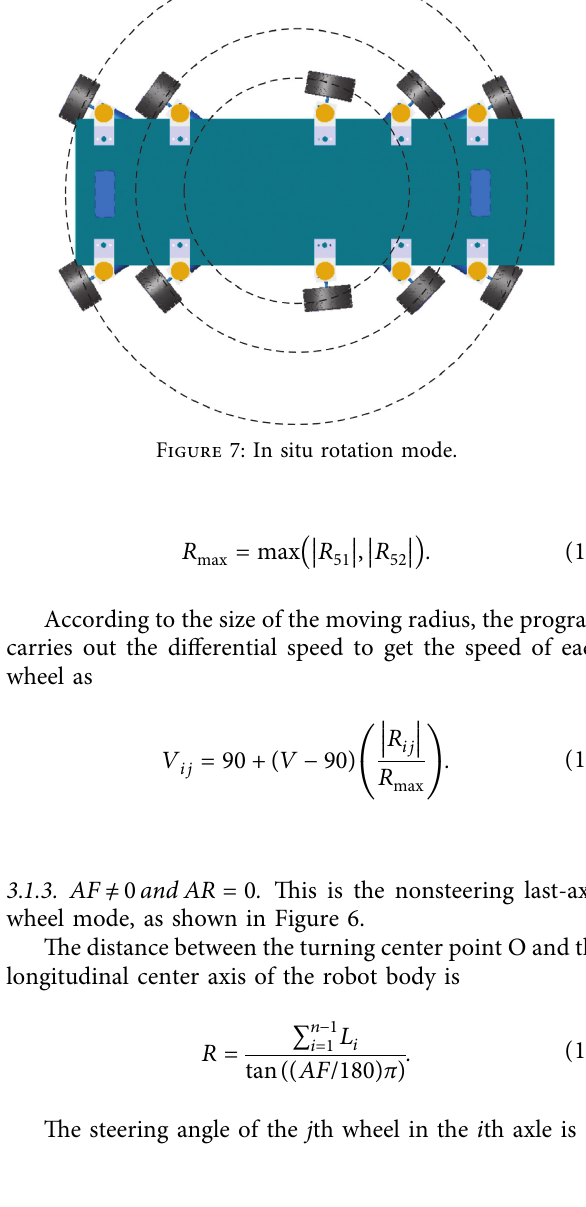
Figure 4: Geometric relation diagram of wheel steering angles in other steering modes of the robot.